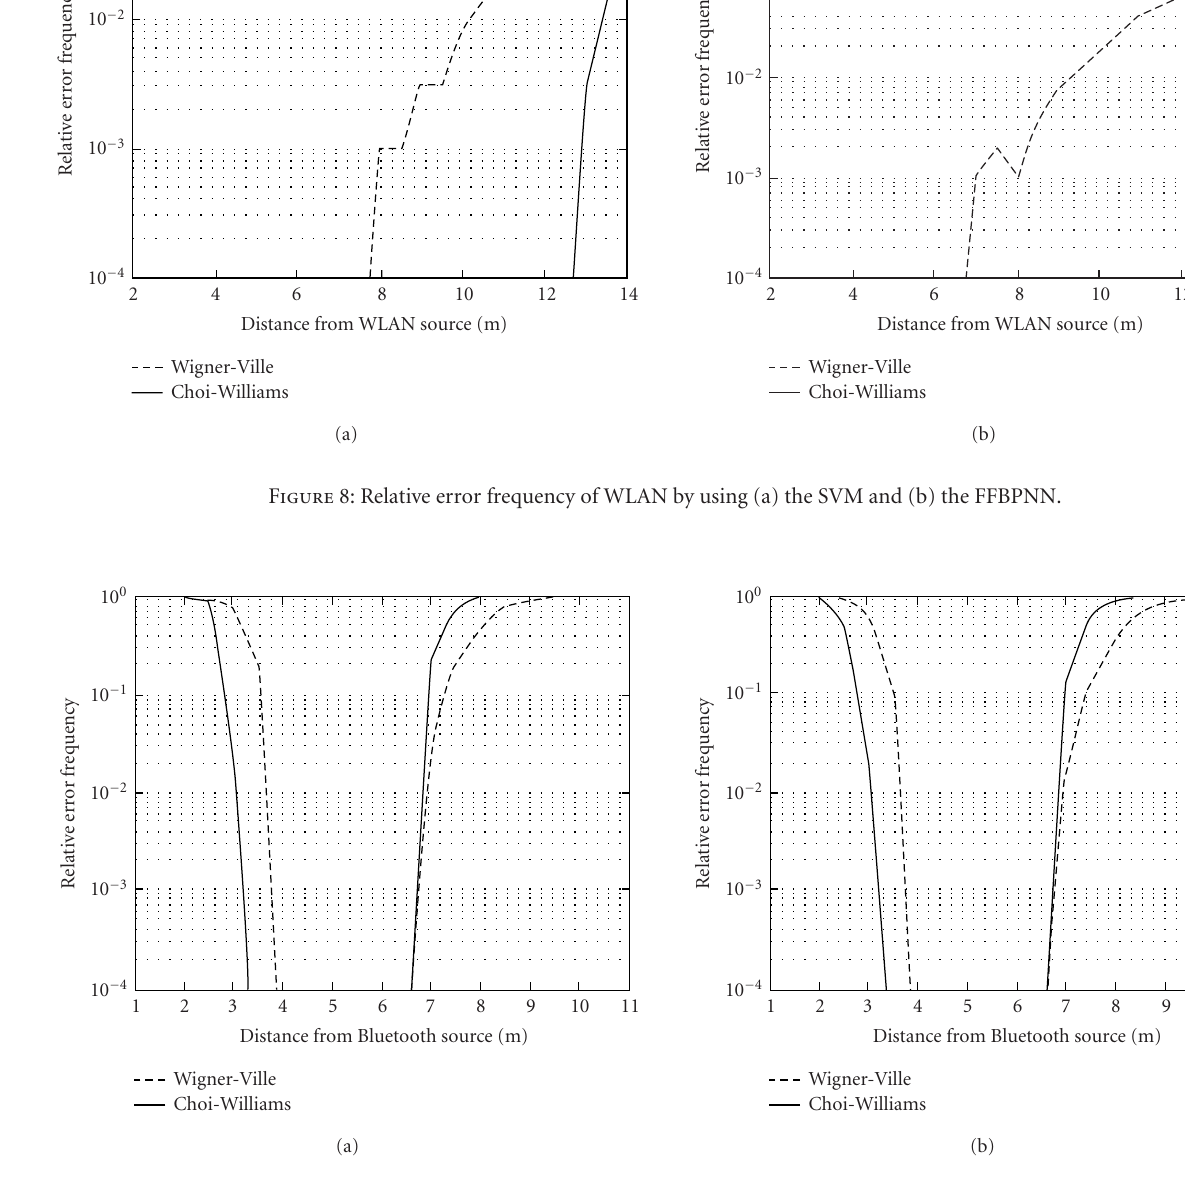
Figure 9: Relative error frequency of WLAN + Bluetooth by using (a) the SVM and (b) the